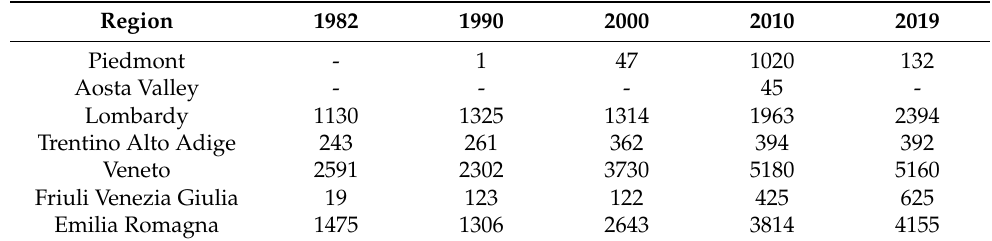
Table 3. Surface area (hectares) of the olive tree in Northern Italy by administrative region and census